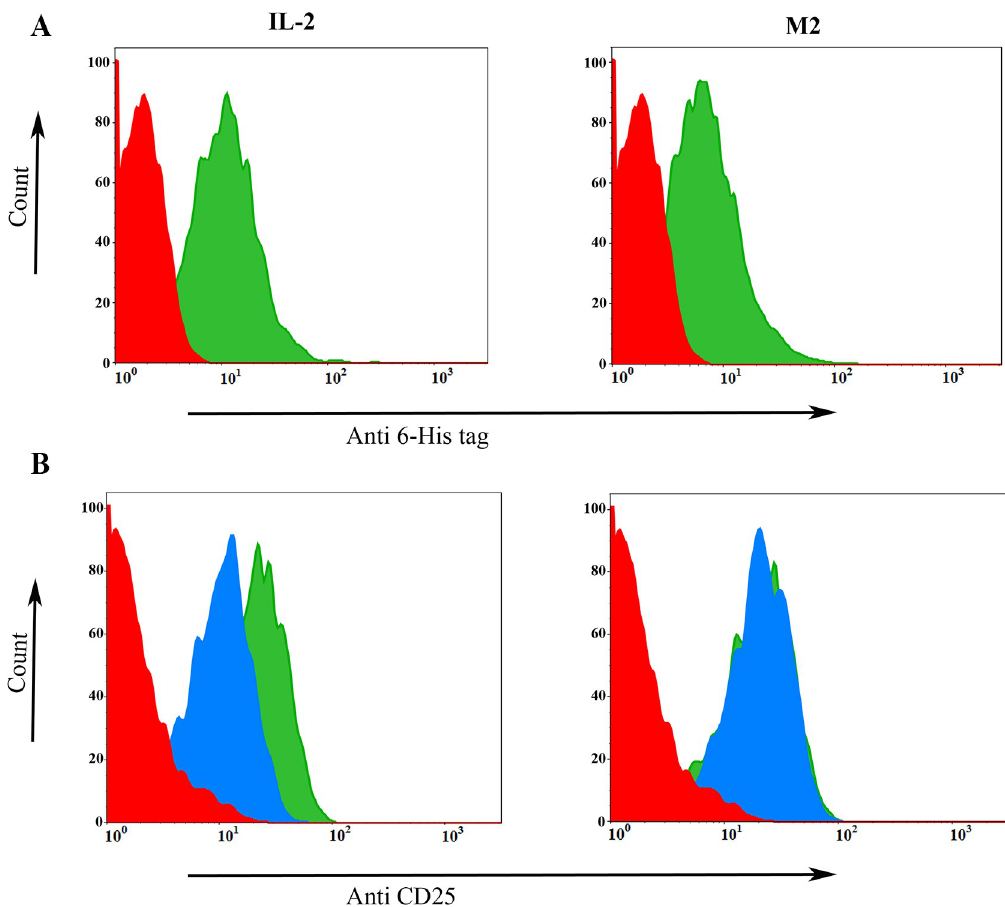
Fig 7. Flow cytometry analysis showing the binding ability of IL-2 mutein to the conA activated PBMC. A. Direct binding, red graph negative control, green graph wtIL-2 (left panel) and mutant IL-2 (right panel) bound to the cells and detected with rabbit anti-His-tag Ab and mouse anti-rabbit FITC-conjugated. B. Flow cytometry analysis showing the competitive assay. Negative control (red graph), cells labeled with anti-CD25 MAb-PE (green), and cells previously incubated with wtIL-2 (blue graph; left panel) or mutant IL-2 (blue graph; right panel) and then labeled with the anti-CD25 MAb-FITC.